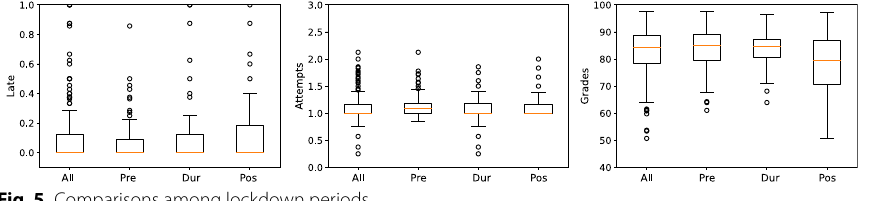
Fig. 5 Comparisons among lockdown periods